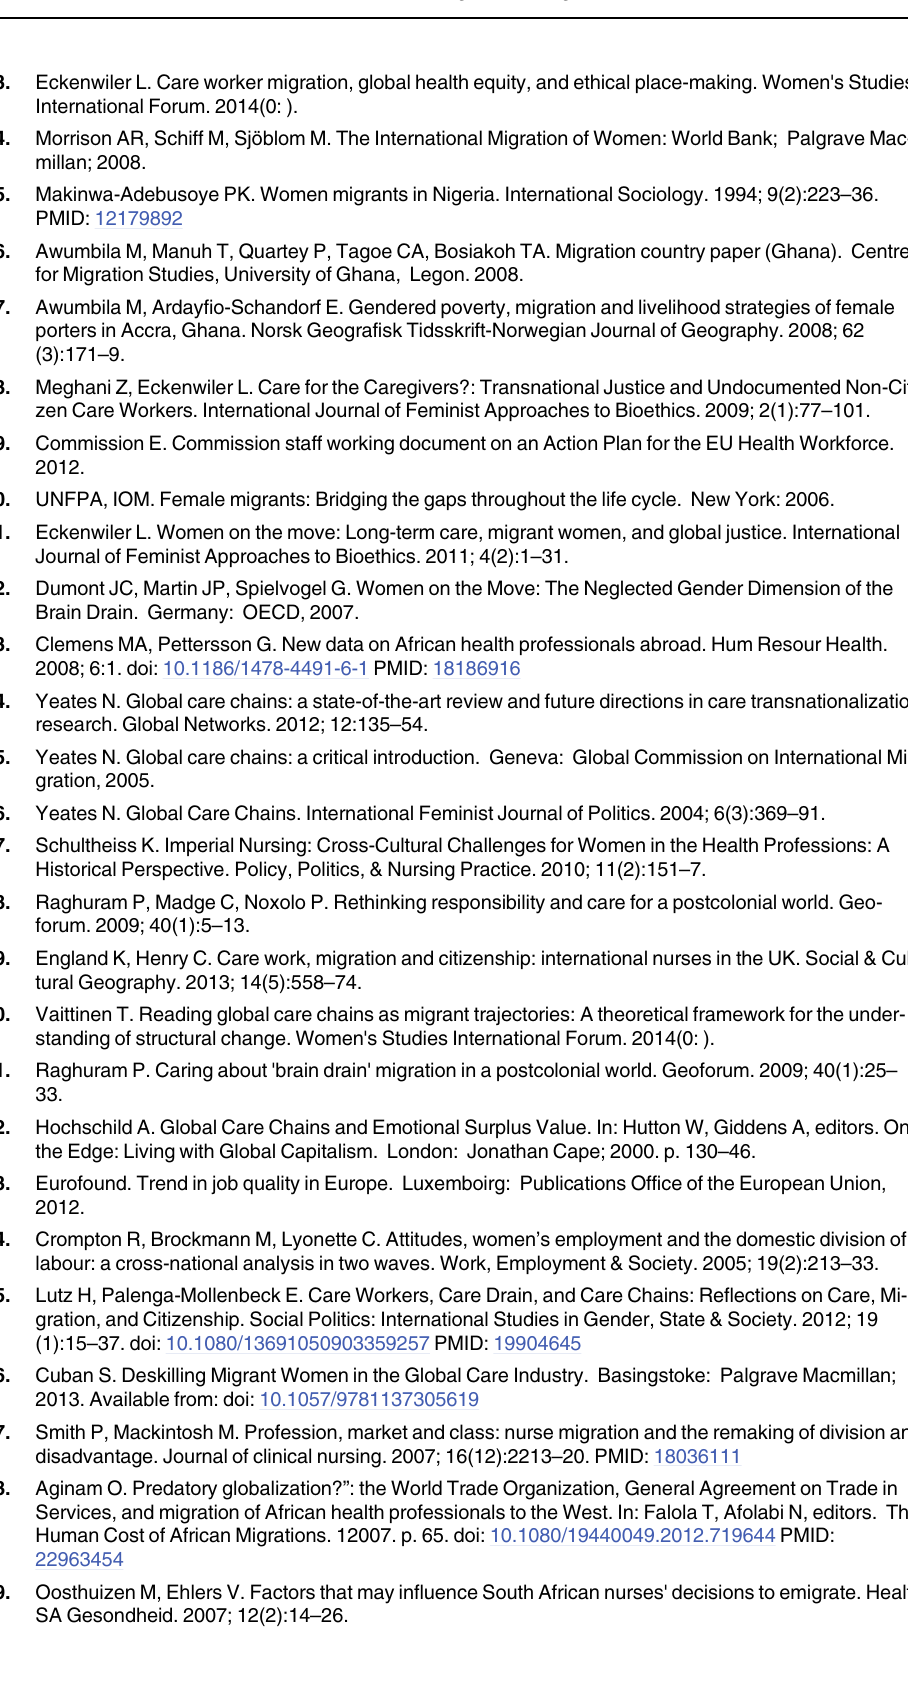
PLOS ONE | DOI:10.1371/journal.pone.0129464 June 12,